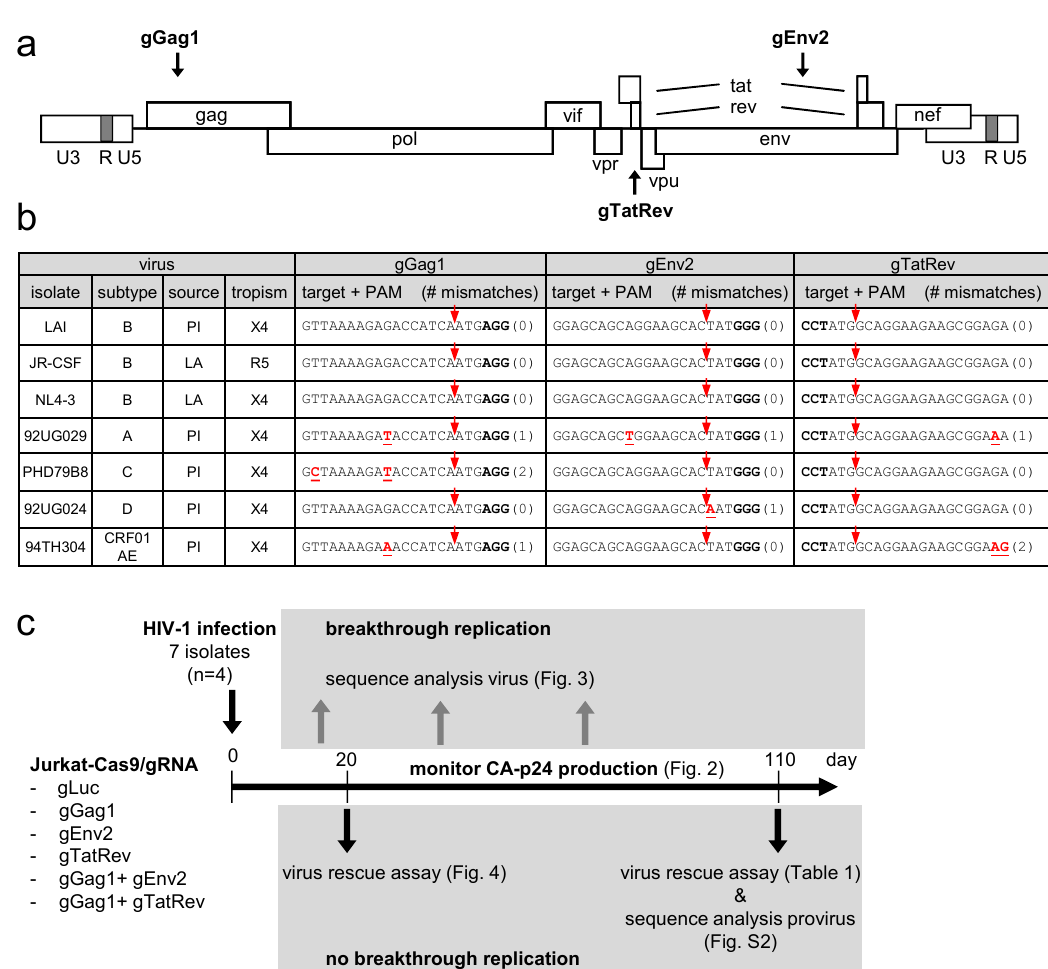
Figure 1. CRISPR-Cas9 targeting of different HIV-1 isolates. ( a ) The HIV-1 proviral genome with the position of the gRNA-target sites indicated. The gRNAs binding to the sense and antisense DNA strand are indicated above and below the proviral genome, respectively. ( b ) Different HIV-1 isolates tested in this study. For each isolate, the subtype, source (PI, primary isolate; LA, laboratory-adapted) and tropism (X4, CXCR4-using; R5, CCR5-using) are indicated. The gRNA-target sequence is shown with nucleotides mismatching with the gRNA in red and underlined (number of mismatching nt indicated between brackets) and the PAM nucleotides in bold. The Cas9 cleavage site is indicated with a red arrow. ( c ) Experimental design. See text for